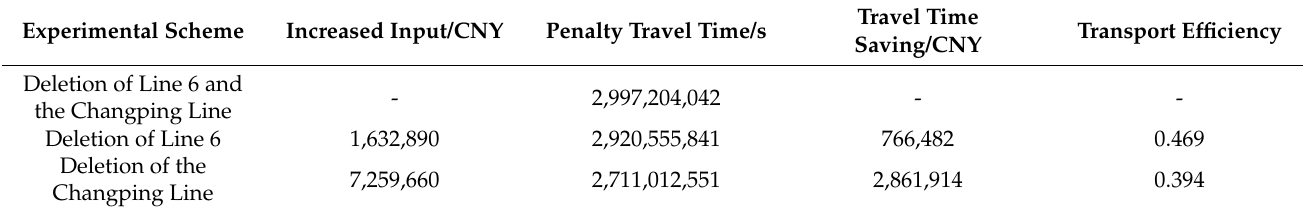
Table 5. Transport Efficiency calculation of line construction